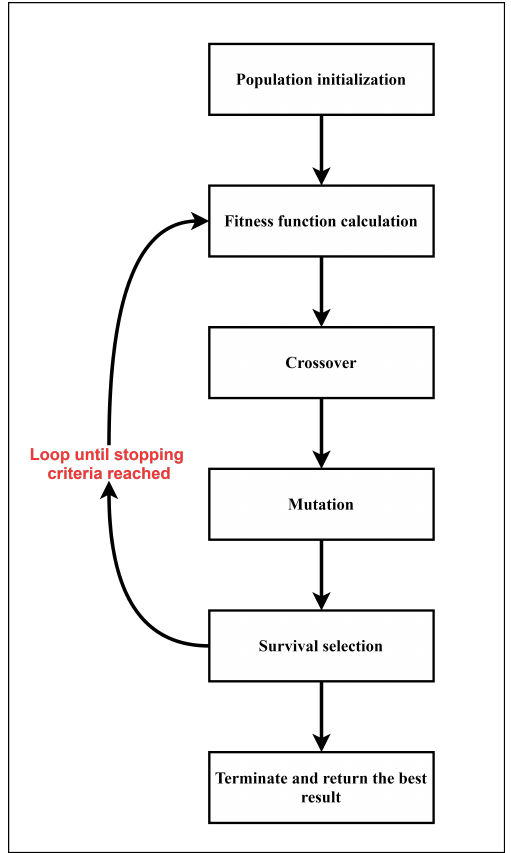
Figure 2. General framework of GA